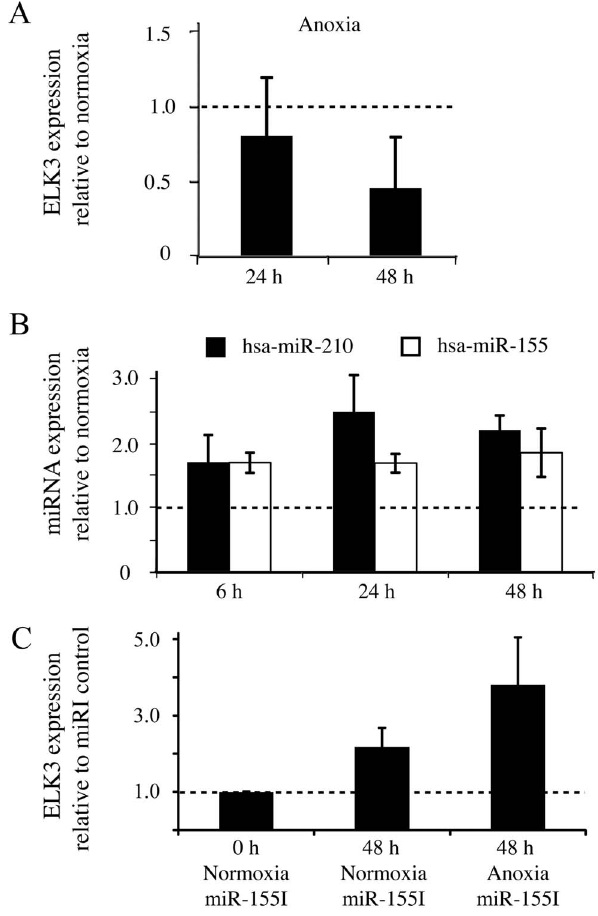
Figure 7. ELK3 mRNA in HUVEC cells is downregulated in anoxia by a mechanism that involves hsa-miR-155-5p. (A) ELK3 mRNA expression in HUVEC at 0% oxygen normalised to 0 h in normoxia (Four separate experiments, error bars represent S.D.). (B) Induction of hypoxamir hsa-miR210-5p and hsa-miR155-5p expression in 0% oxygen. Three separate experiments, error bars represent the S.D. between experiments. miR expression is normalized to normoxia 0 h. (C) ELK3 mRNA expression under anoxia (0% oxygen) after treatment with the miR-155 inhibitor (miR-155I, see Table S1 in File S1 ) relative to the inhibitor control. Three separate experiments, error bars represent the S.D.